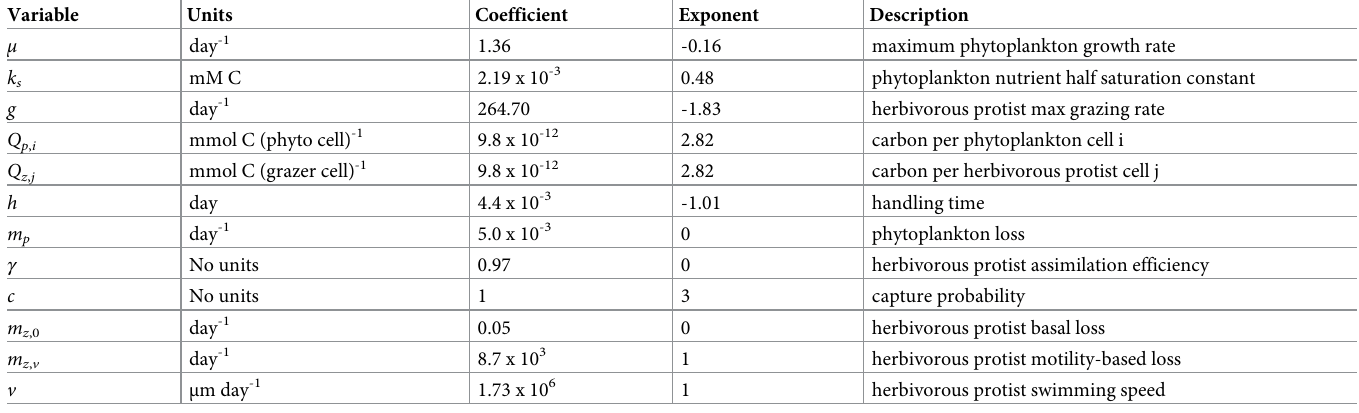
Table 2. Size-dependent variables. The coefficient and exponent values typically correspond to a and b , respectively, in the allometric relationship r = as b for s the diame- ter of the cell in μ m and r the rate or property. Exceptions include g , which takes the form in Eq (4), h , which takes the form in Eq (5), and c , which takes the form in Eq (7). NA means not